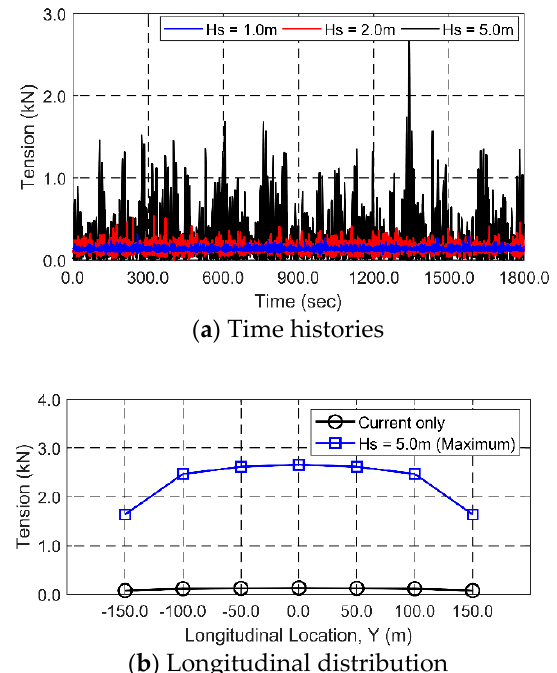
Figure 10. Time histories of the mooring tension at the middle location (top mooring line) under different wave conditions (a) and the corresponding spatial distribution along the net length at H s = 5.0 m and T p = 10.0 s (b)(current velocity = 0.6 m/s).